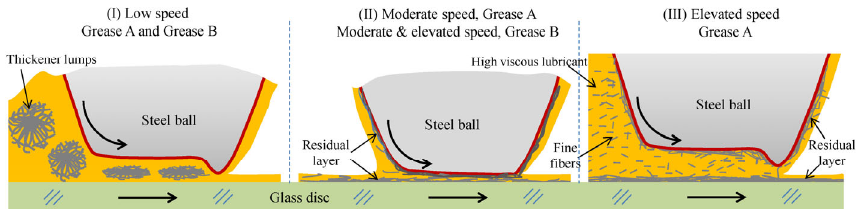
Fig. 13 Schematic of lubrication states over different speed